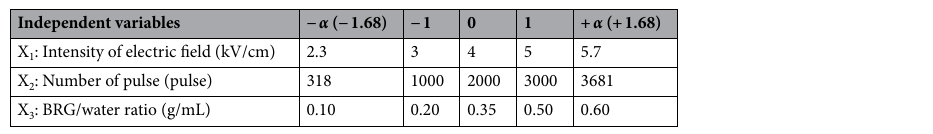
Table 1. Code levels of independent variables for PEF-AE using CCD.